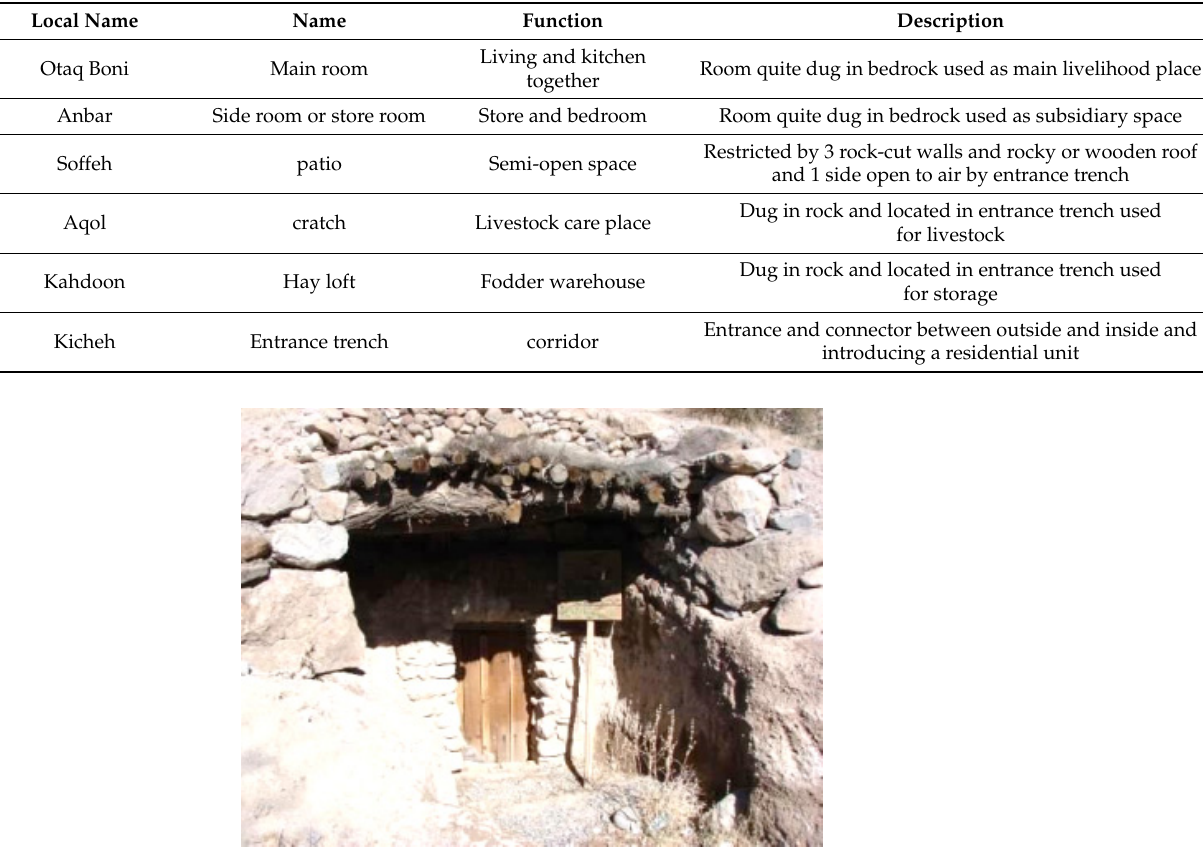
Figure 24. Hippophae wood and wormwood shrubs form the canopy of a house in Meymand vil- lage.